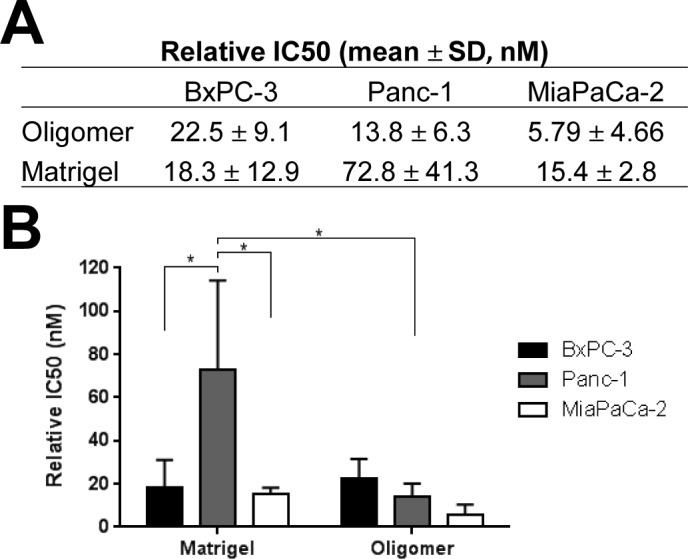
Sensitivity of PDAC lines to gemcitabine depends on 3D matrix type.(A) Table and (B) graph summarizing gemcitabine IC50 values (mean ± SD) for PDAC lines cultured (2x105 cells/mL) for 4 days within Oligomer (0.9 mg/mL, 100 Pa) or Matrigel (100 Pa). Asterisk (*) indicates statistically different groups (p<0.05, N = 3–4, n = 3).